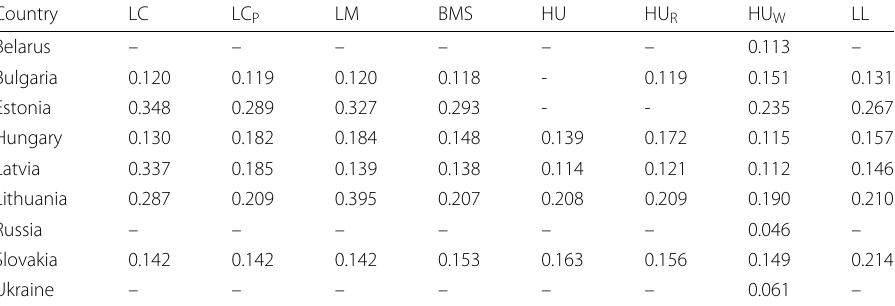
Table 6 One-step-ahead forecast bias of the fitted models in terms of MAE considering harmonized fitting